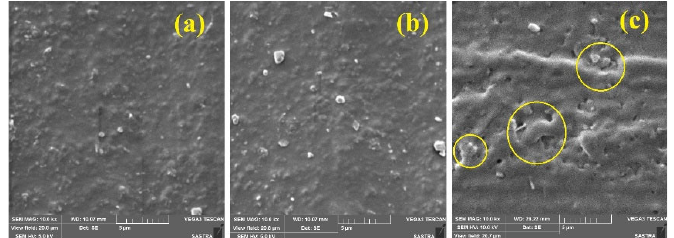
Figure 1. Scanning electron microscope images of ( a ) 5%; ( b ) 10%; ( c ) 15% Nano SiO 2 filled silicone rubber.